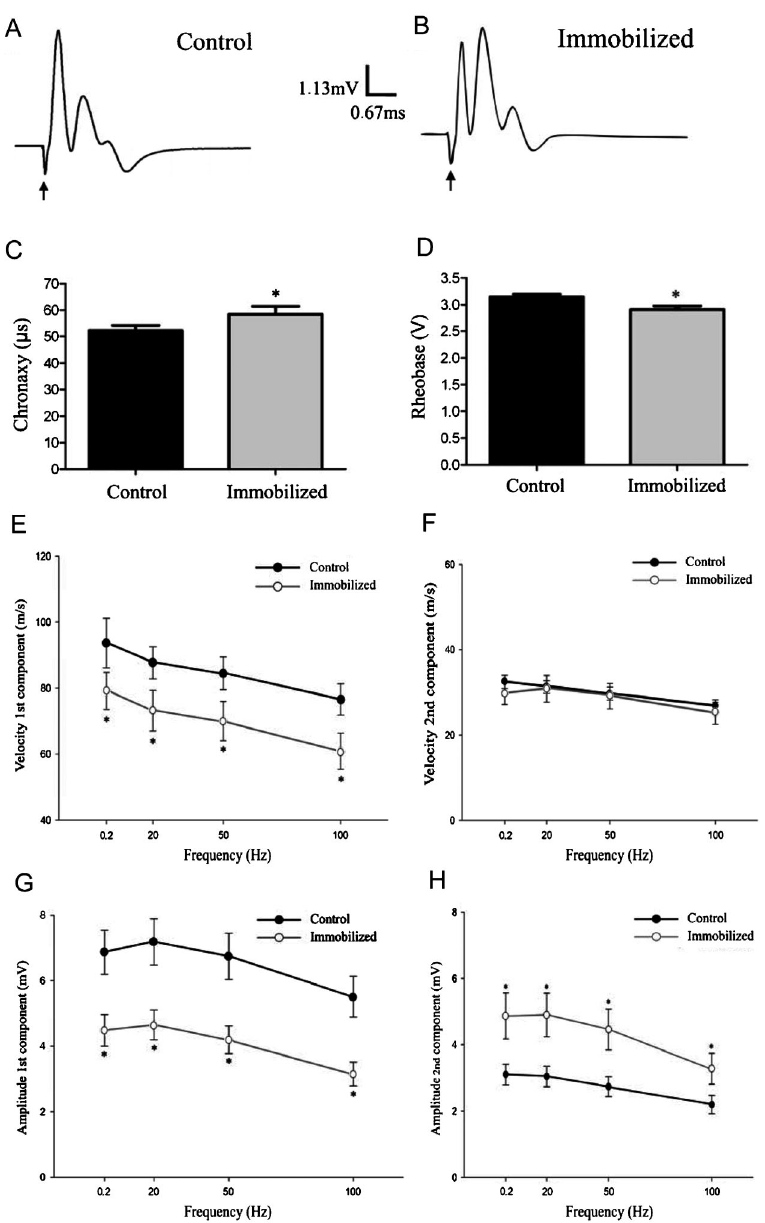
Figure 1. Effect of immobilization on compound action potential (CAP) parameters. A and B show representative CAP tracings in control ( A ) and immobilized ( B ) rats. C and D show chronaxy ( C ) and rheobase ( D ) in control and immobilized rats. E , F , G , and H show conduction velocity of first ( E ) and second ( F ) components and positive amplitude of first ( G ) and second ( H ) components of CAP at different frequencies in control and immobilized rats. Data are reported as means±SE (n=13 and n=15 for control and immobilized rats, respectively). *P , 0.05 control vs immobilized ( C and D , non-paired Student t -test; E , F , G and H , at a given frequency, ANOVA followed by the Bonferroni post hoc